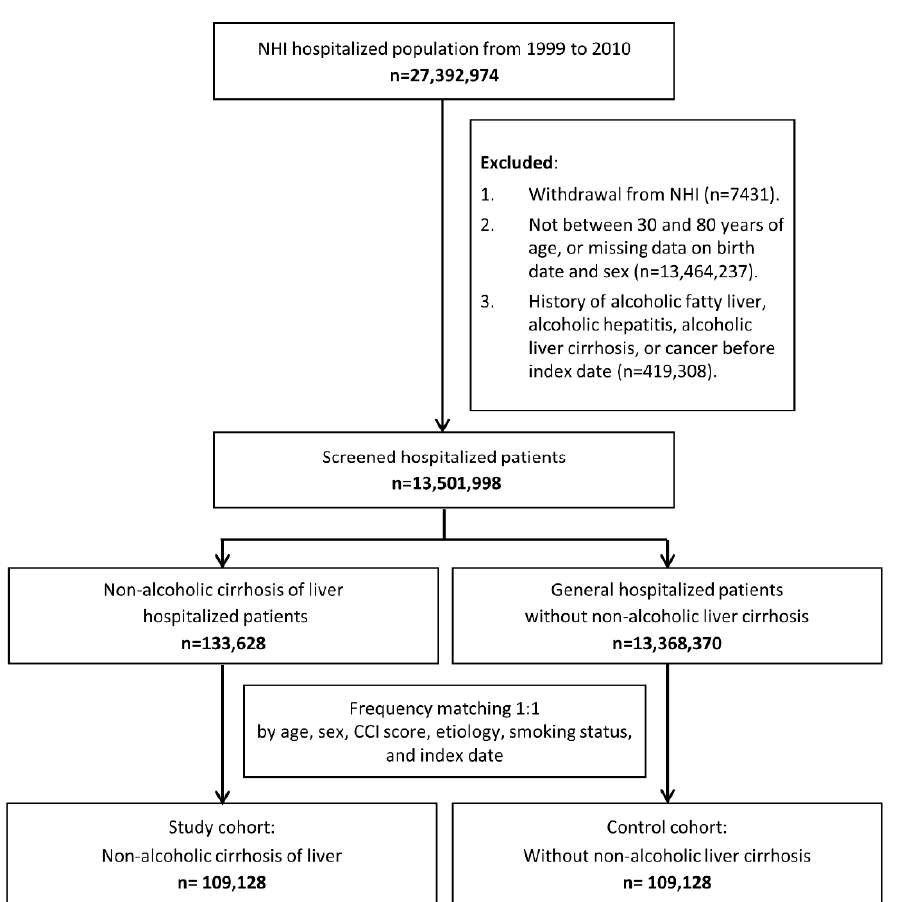
Figure 1. Subject selection process flowchart.